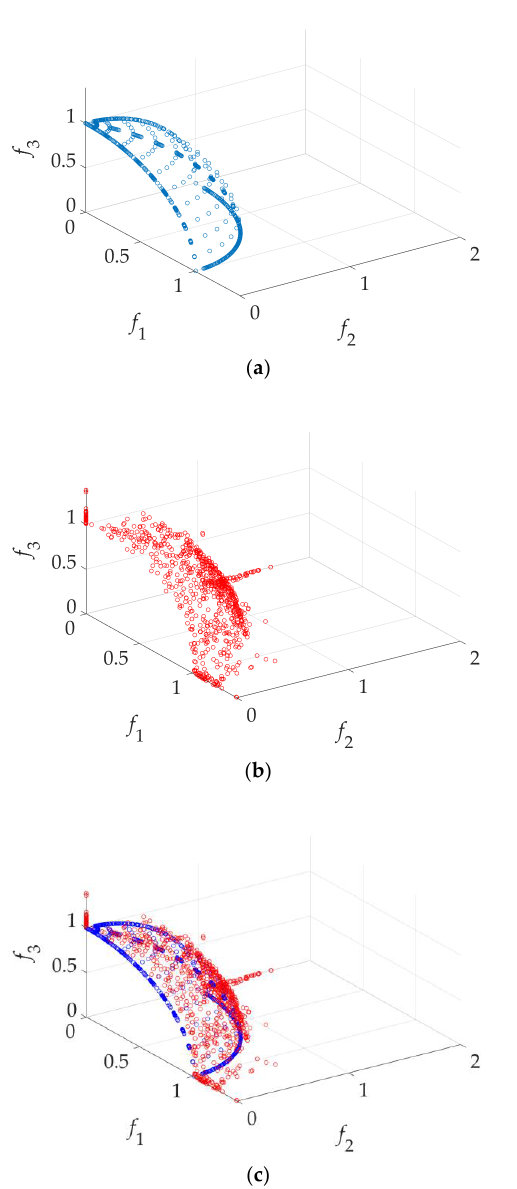
Figure 9. Approximate Pareto fronts of DTLZ2 ( n = 9): ( a ) obtained by GSDP; ( b ) obtained by NSGA-II; ( c ) comparison between GSDP and NSGA-II. Table 1. Comparison results of GSDP and NSGA-II methods. DCI: Diversity Comparison Indicator. Functions (Dimension of